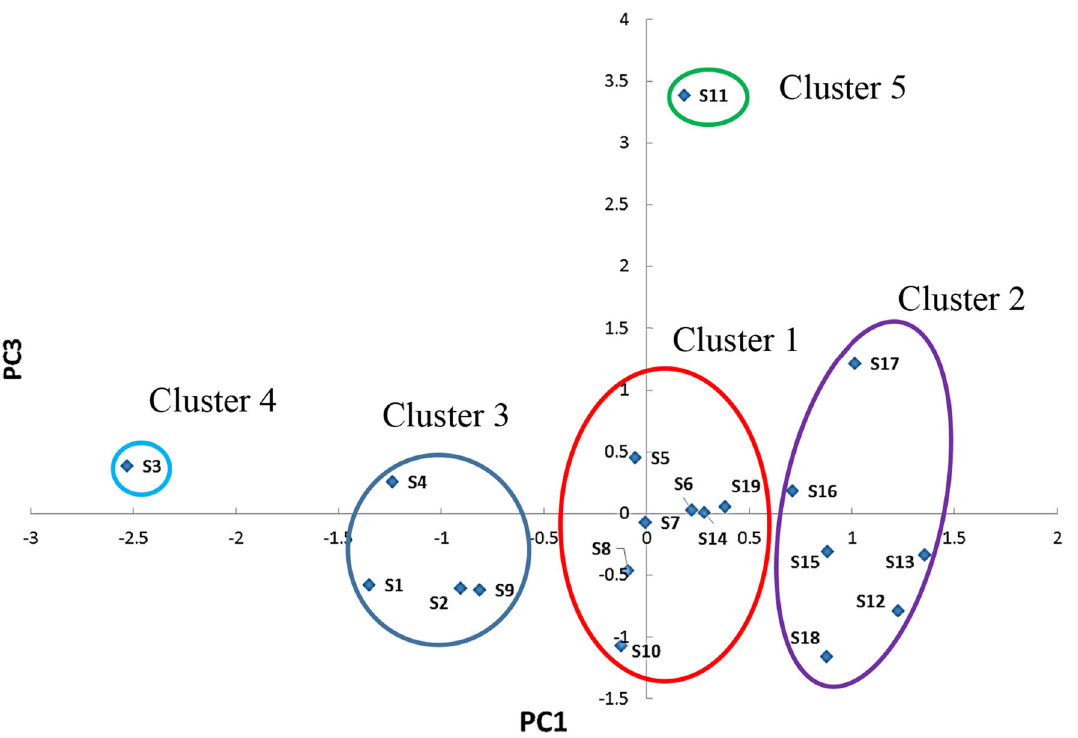
Fig. 10 Plots of PC1 vs. PC3 showing groupings among sampling